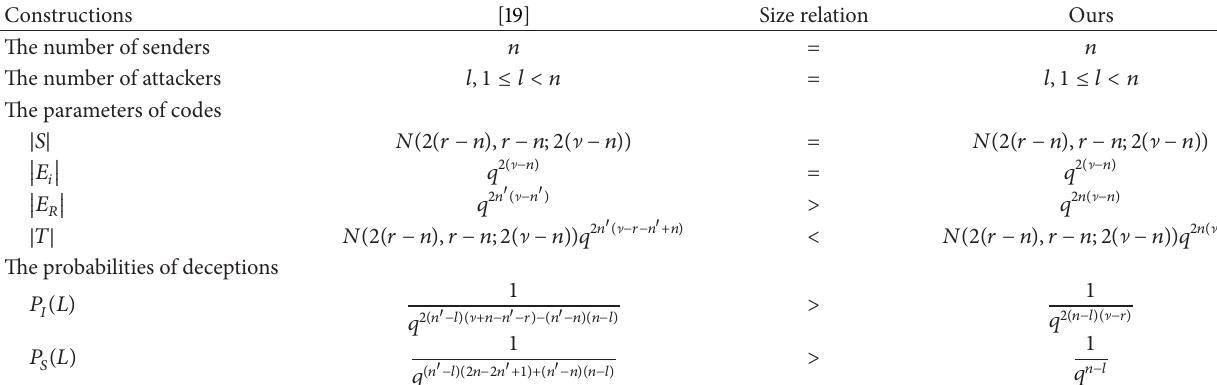
Table 1: (𝑛 > 𝑟/2, 𝑛 󸀠 − 𝑛 > ] − 𝑟)